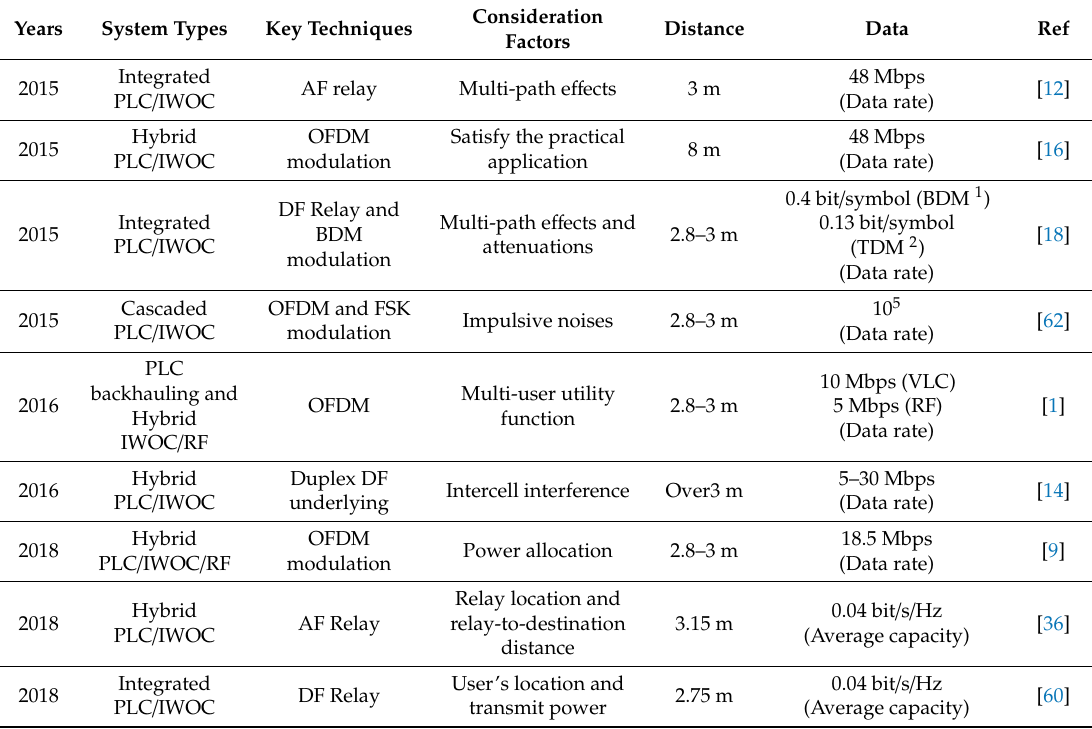
Table 2. Comparison of di ff erent researches between PLC and IWOC